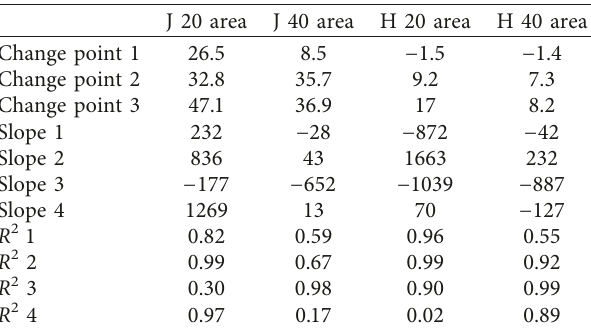
Figure 3: Areas occupied by all 20 and 40dB Z polygons for Humberto (H) and Jeanne (J) aligned by time after landfall. Letters correspond to change points in Table 3. Table 3: Results of change point analysis for areas of 20 and 40 dB Z regions with time of change point in hours after landfall, slope of trend line in between each change point in sq. km · hr − 1 , and the coefficient of determination for each trend